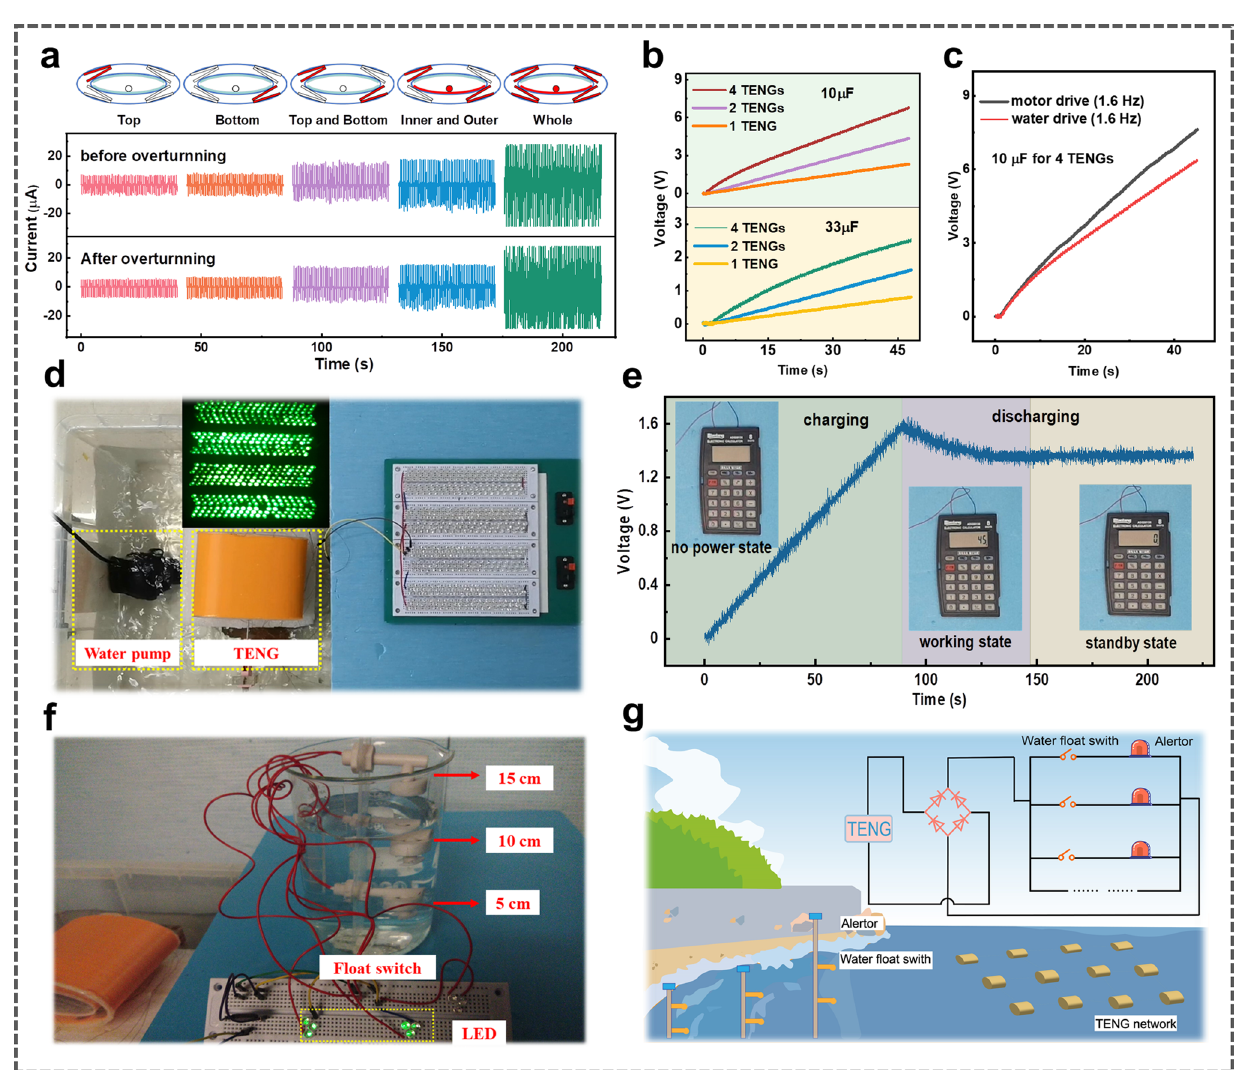
Fig. 5 Demonstrations of the EC-TENG for wave energy harvesting. a Short-circuit current of the device before and after overturning. b Volt- age profiles of several commercial capacitors charged by different sets of outer TENGs when the device is driven by a water wave. c Comparison of charging performances of stepper motor excitation and water wave triggering. d Image of 400 green LEDs lit by EC-TENG. e The voltage profile for an electronic calculator powered by the EC-TENG, where the insets show the working states of the electronic calculator. f Image of a water-level monitoring system powered by the EC-TENG. g A blueprint of the conceived EC-TENG-based water-level monitoring system for monitoring the coastal water levels, where the inset shows the circuit diagram of the water-level monitoring